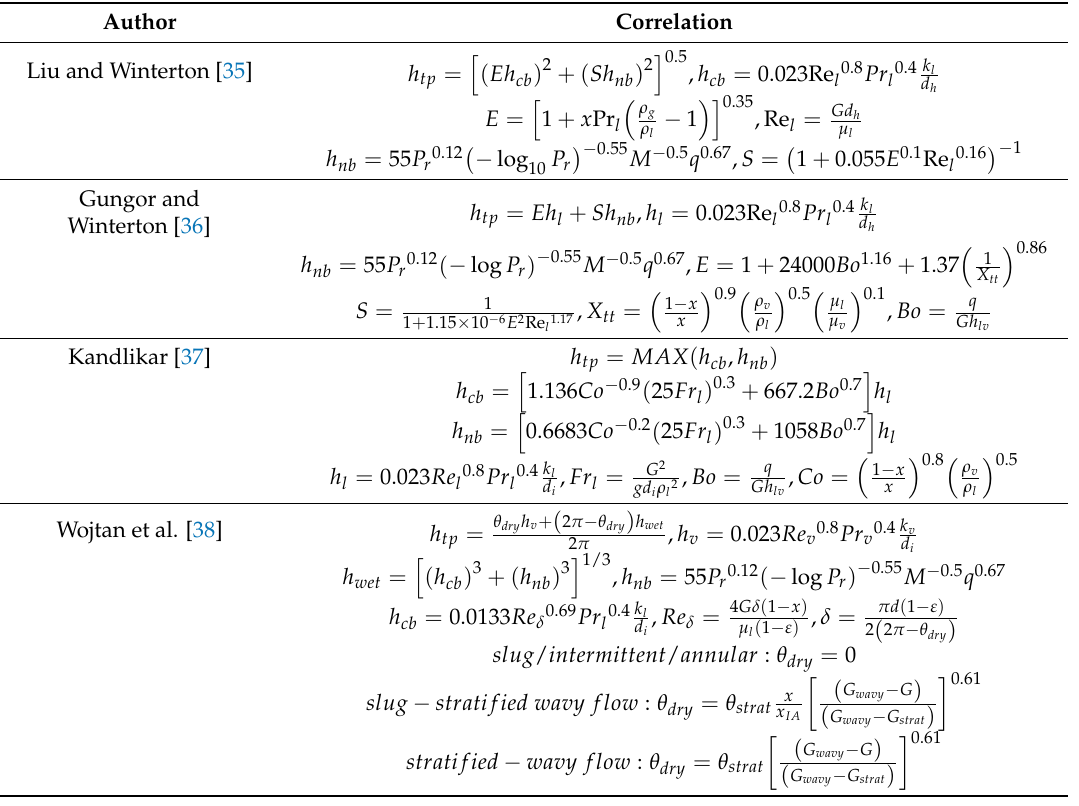
Table 6. Details of four existing correlations for evaporation heat transfer.